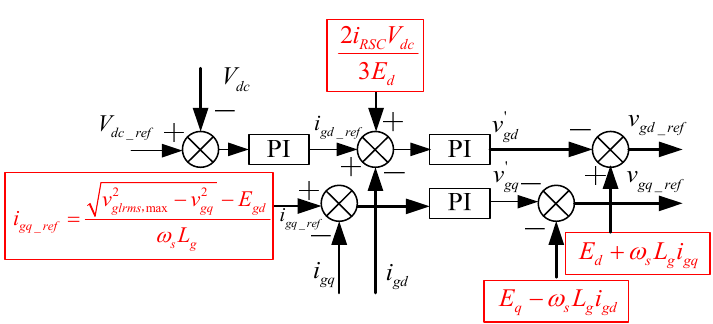
Figure 9. Enhanced control of the